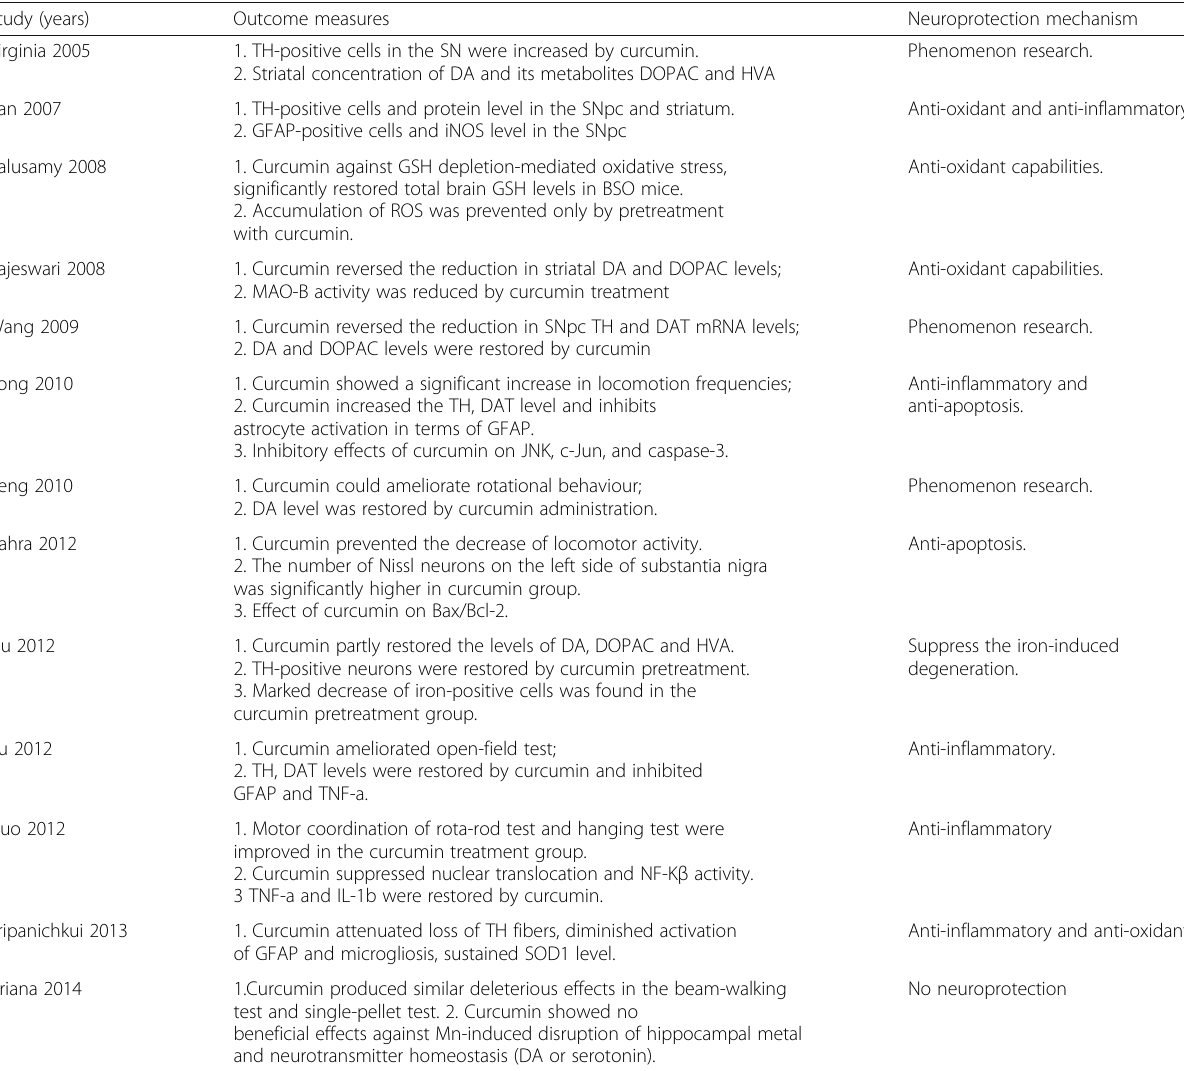
Table 3 Main outcome measures of included studies Study (years) Outcome